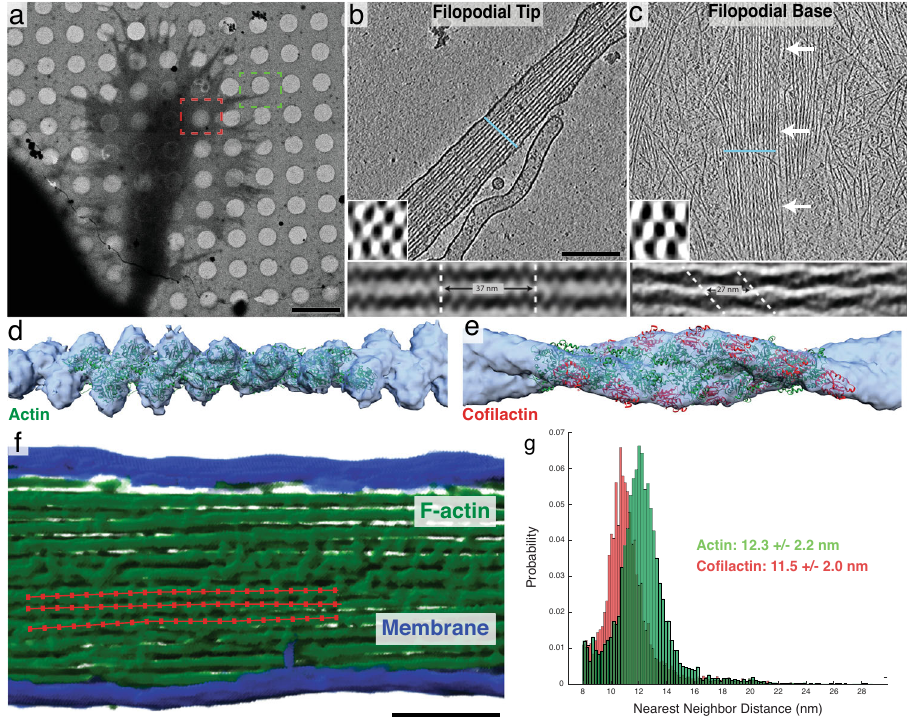
Fig. 2 Structural features of neuronal growth cone fi lopodia and their associated co fi lactin bundles. a Overview image of a cryo-preserved growth cone on a Quantifoil EM grid. The green and red boxes represent growth cone regions similar to where the tomograms in b and c were imaged, respectively. b , c 5 nm-thick slices of tomograms from the tip ( b ) and base ( c ) of growth cone fi lopodia. In b , a bundle of actin fi laments fi lls the entire cytoplasm. In c , branched networks of individual actin fi laments can be seen surrounding a central bundle of hyper-twisted co fi lactin fi laments. White arrows point to the bundle. Lower-left insets: 68 nm-thick transverse cross-sections through each bundle, illustrating the hexagonal packing of fi laments. The blue line in the main images show the plane from which the insets were taken. Bottom insets: Subtomogram averages of fi lament pairs in fi lopodial tips (below b ) or in co fi lactin bundles at the fi lopodial bases (below c ). Co fi lactin fi laments have a shorter helical twist than F-actin and are out of phase with adjacent fi laments. d EM map (blue) resulting from the subtomogram averaging of actin fi laments in fi lopodial tips, and rigid body fi tting of a previously reported atomic structure for F-actin (PDB ID: 6T1Y; green). e EM map (blue) resulting from the subtomogram averaging of co fi lactin fi laments near the base of fi lopodia, and rigid body fi tting of a previously reported atomic structure of co fi lactin (PDB ID: 3J0S; actin is green and co fi lin is red). f Segmented fi lopodial protrusion with a schematic of fi lament centerlines overlaid (red). These lines are comprised of a series of points that were used for nearest neighbor analysis. g Nearest neighbor histograms showing the cumulative total of three normal actin fi lopodial bundles (green) and three co fi lactin bundles (red). Scale bars: ( a ) 5 µ m, ( b ) 200 nm (this also corresponds to the image in c ), f 100